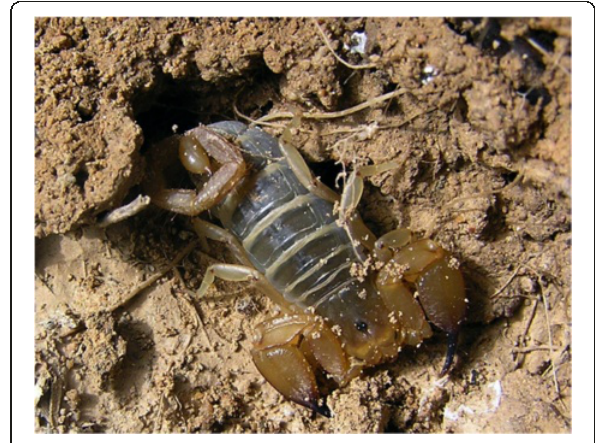
Fig. 14 Hemiscorpius lepturus Peters, 1861; female from Iran (copyright by Philippe Geniez, reproduced with